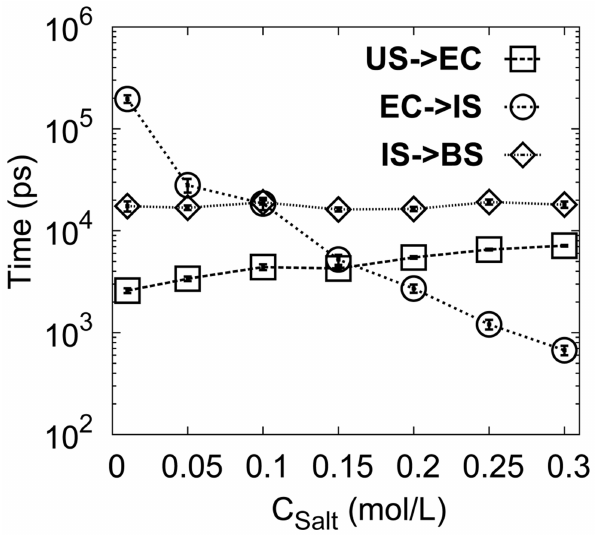
Figure 5. MPT as a function of C Salt . C Salt is the salt concentration. The error bar represents the standard error of the corresponding MPT.